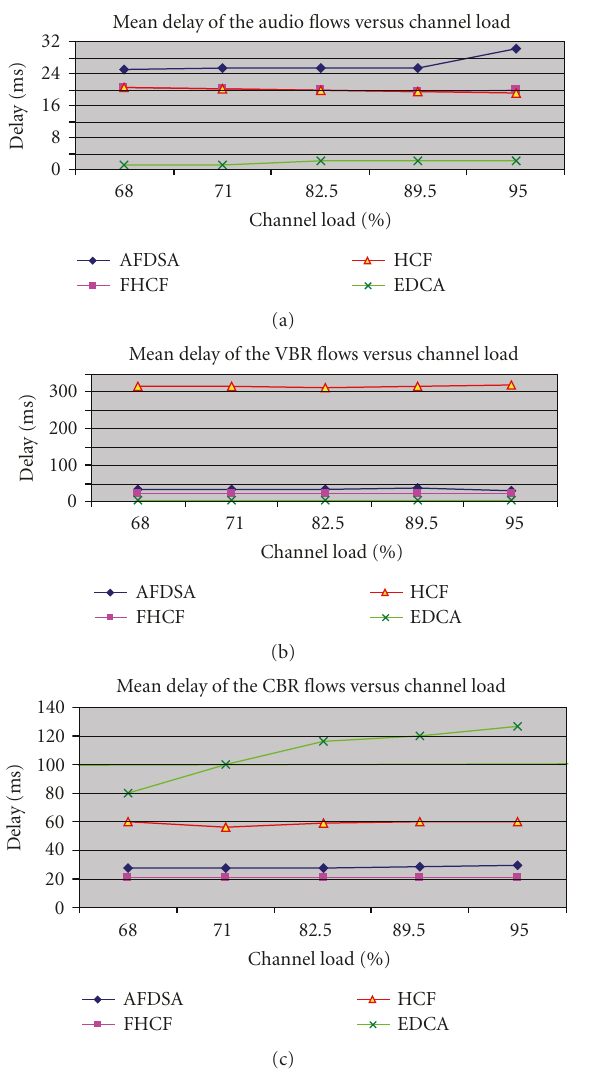
Figure 18: Mean latency for di ff erent flows versus channel load. Figure 19: Mean fairness of di ff erent flows versus channel load.